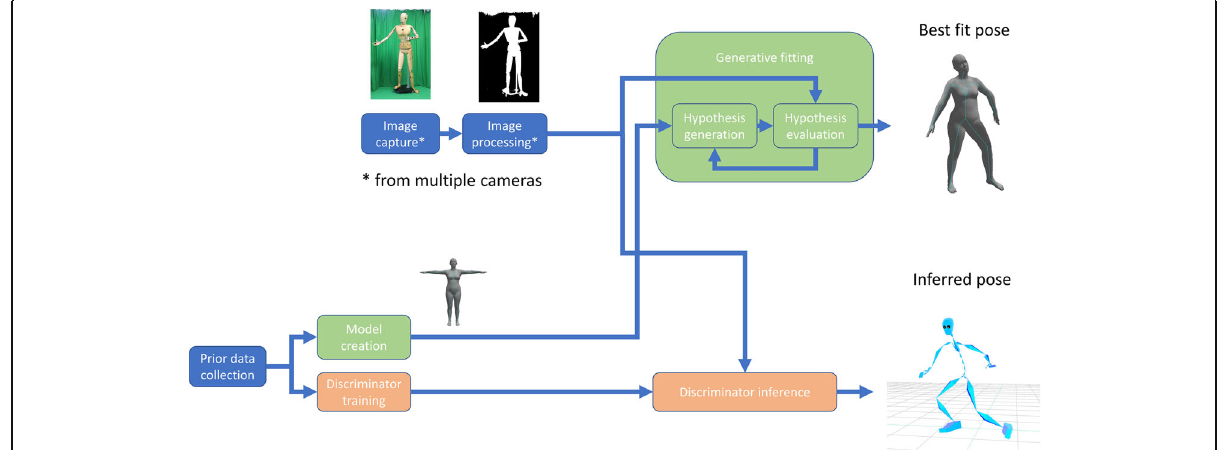
Fig. 1 General structure of a markerless motion capture whether using generative (green) or discriminative (orange) algorithms